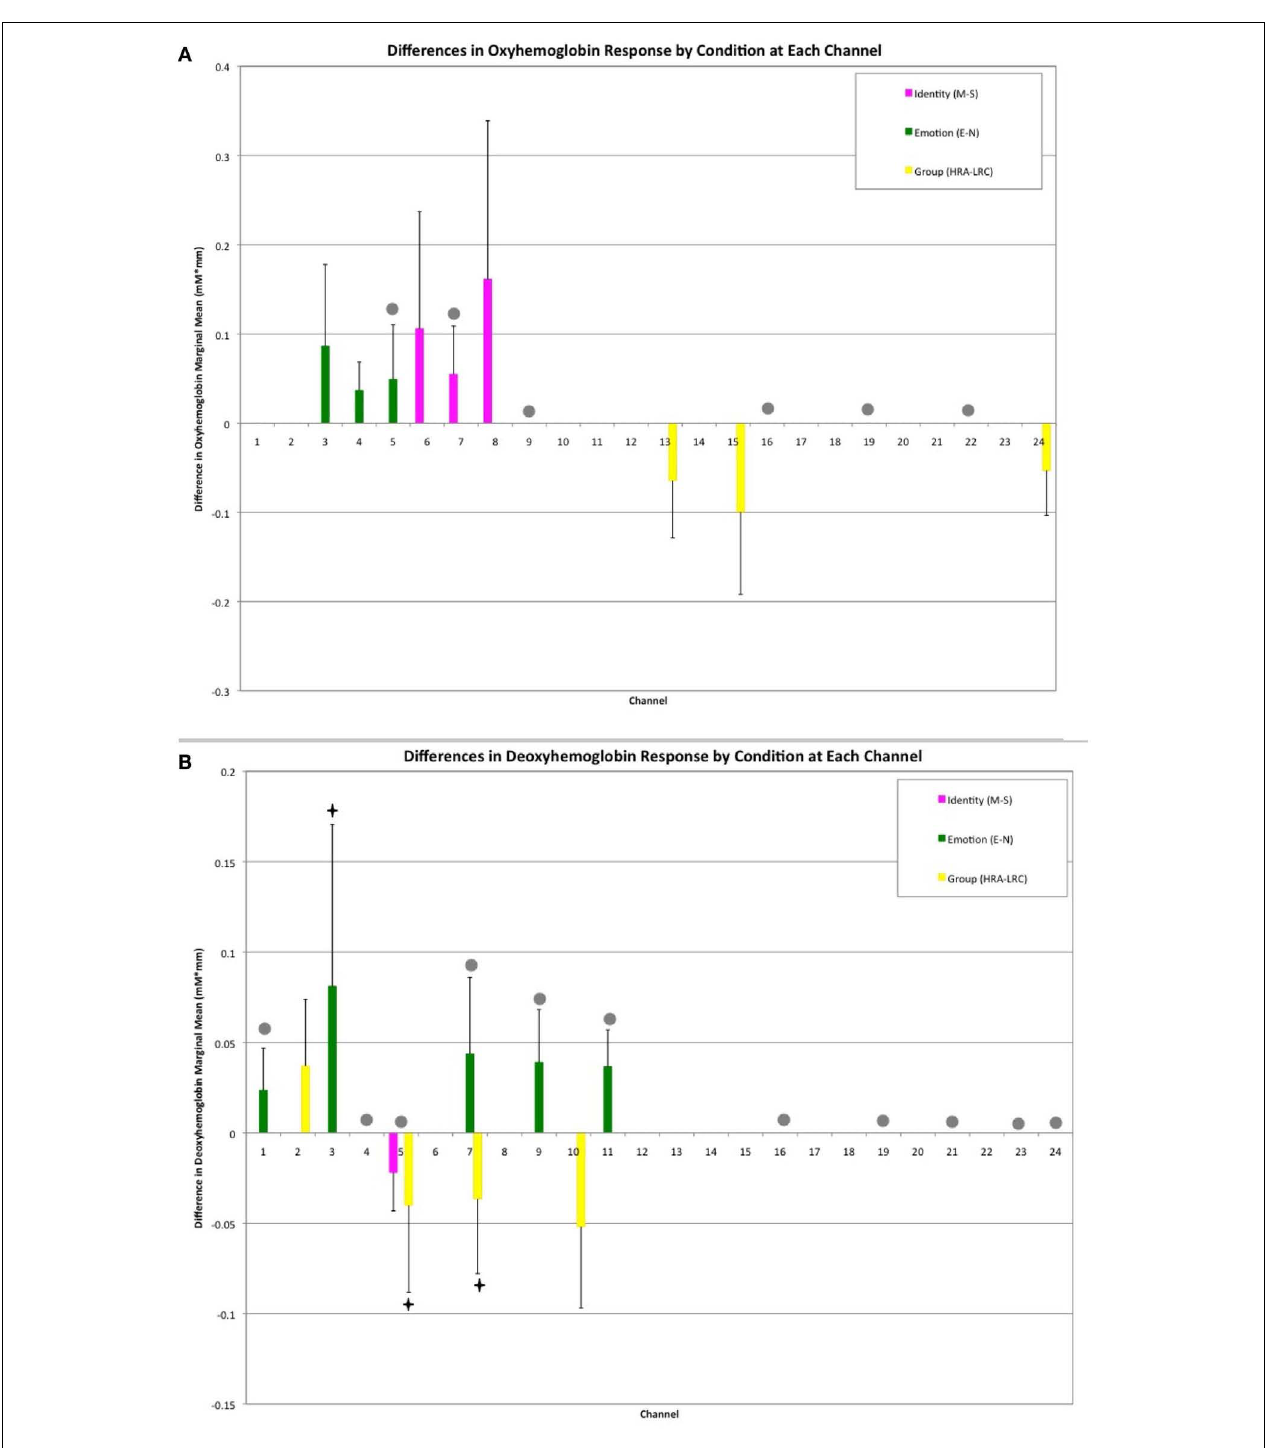
means with corresponding 95% confidence intervals,Tukey’s HSD used for correction for multiple comparisons. Bonferroni correction was employed for correction of comparisons across channels. Marginally significant effects are indicated by “ (cid:7) ” (full statistics in TableA1 in Appendix). Significant interactions were seen across frontal and lateral channels (gray circles). Further information regarding interactions is available in Table 1